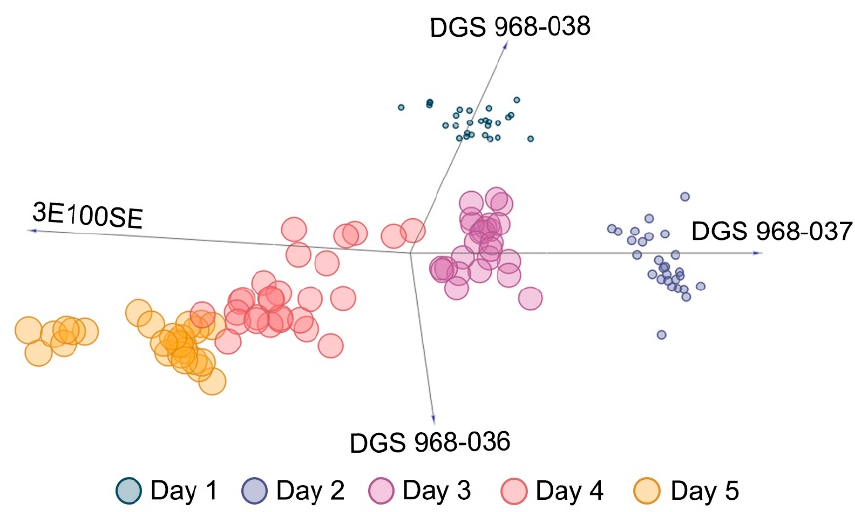
Figure 3. A projection of the four input variables for the training of the regression model; the size of the data points is directly proportional to the corresponding BAI value.